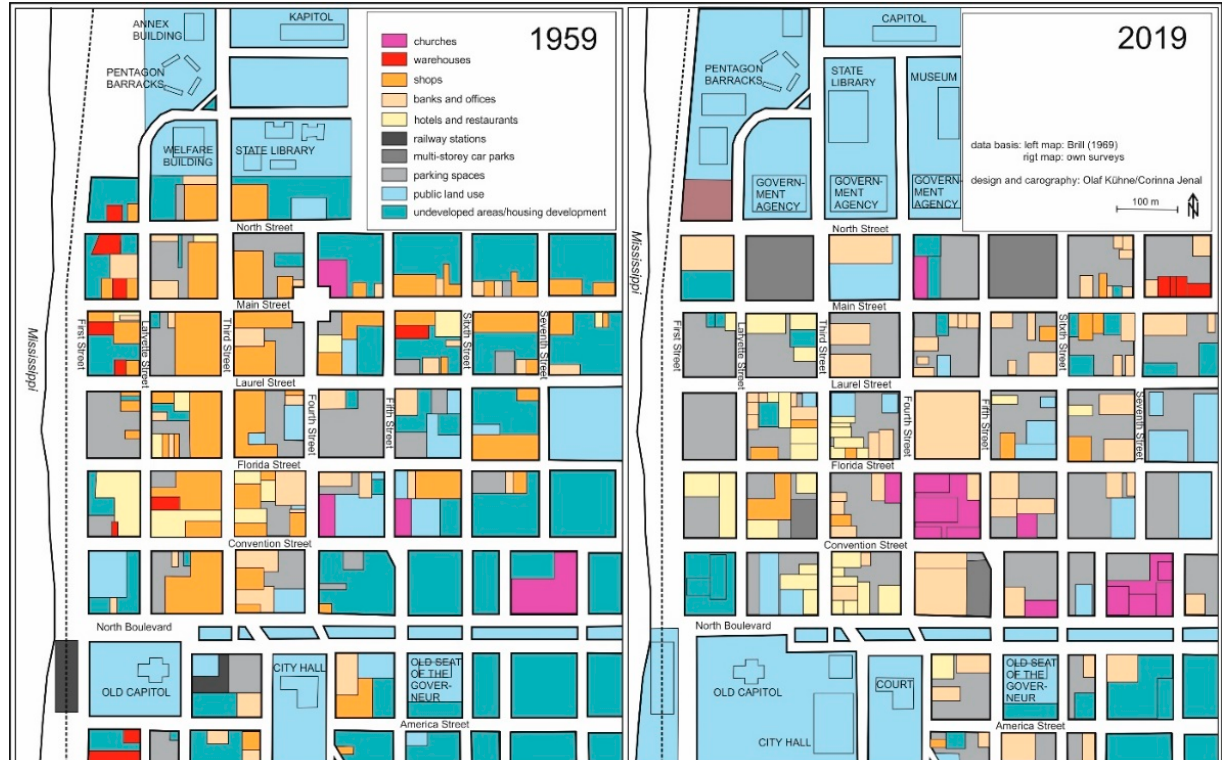
Figure 7. The land use of the downtown area comparison, 1959 and 2019 (own illustration [37]). The consequences of dependence upon the petrochemical industry, combined